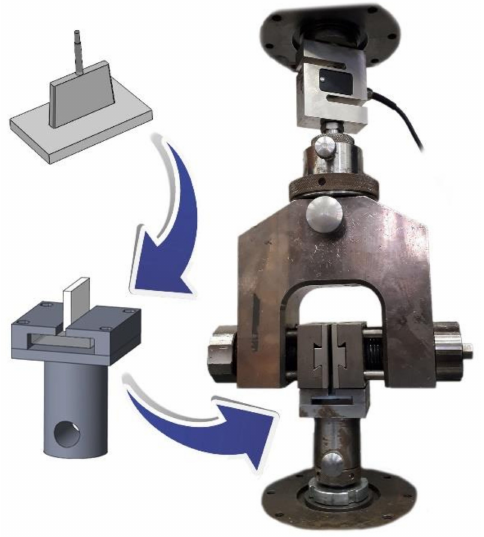
Figure 3. The special grip for the rib pull-off